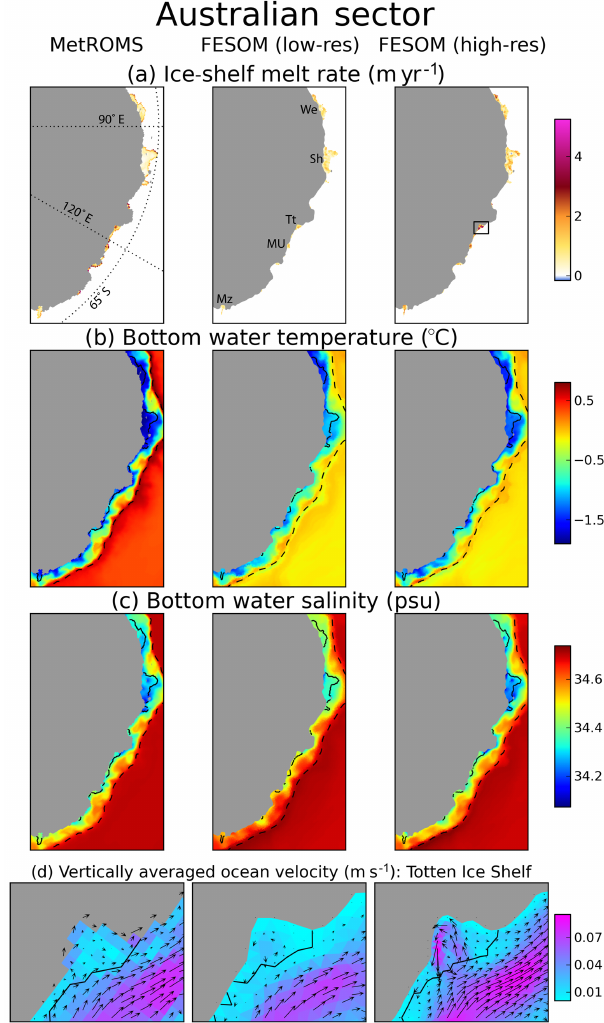
Figure 14. (a) – (c) As Fig. 11a, c, and d for the Australian sector ice-shelf cavities. The dashed black lines in panels (b) and (c) show the 1500m isobath, which approximates the continental shelf break. (d) As Fig. 11b, zoomed into the Totten Ice Shelf cavity (region out- lined in the rightmost panel of panel a ). We indicates West Ice Shelf, Sh indicates Shackleton Ice Shelf, Tt indicates Totten Ice Shelf, MU indicates Moscow University Ice Shelf, and Mz indicates Mertz Ice